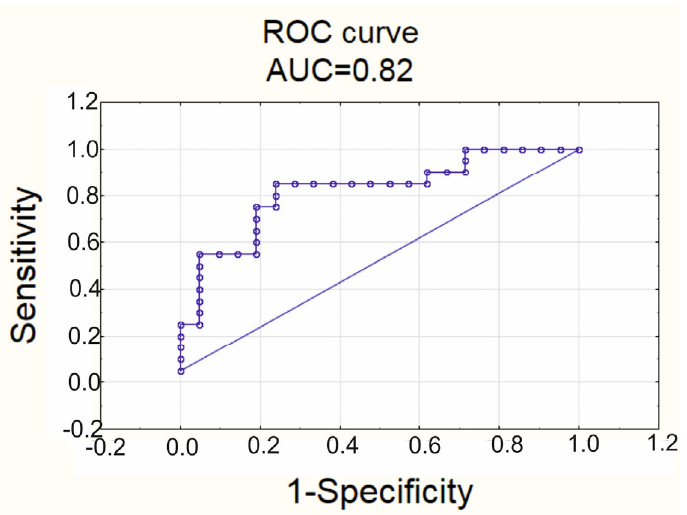
Figure 4. ROC curve of the multiple logistics regression for classification of patients into groups 1 and 2 with different hypertrophy of EAT adipocytes